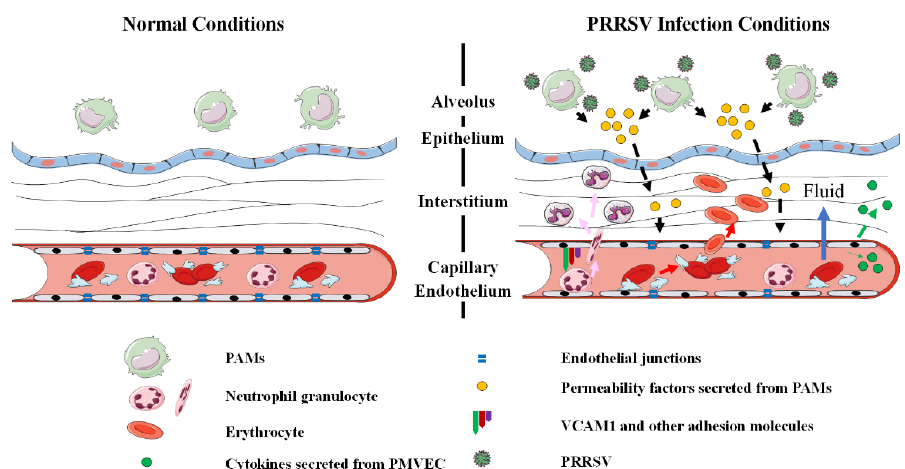
Figure 8. A proposed model for PRRSV dysregulation of the PMVECs barrier. HP-PRRSV-infected PAMs produce secreted permeability factors and use paracrine signaling to communicate with the endothelial barrier during PRRSV infection. PMVECs secrete pro-inflammatory cytokines and express cell adhesion molecules on the surface of pulmonary microvascular endothelium in response to viral infection to aggravate inflammation and monocyte chemotaxis. Conversely, cell–cell junctions between adjacent endothelial cells might be disassembled to promote monocytes, erythrocytes, and fluid flux into